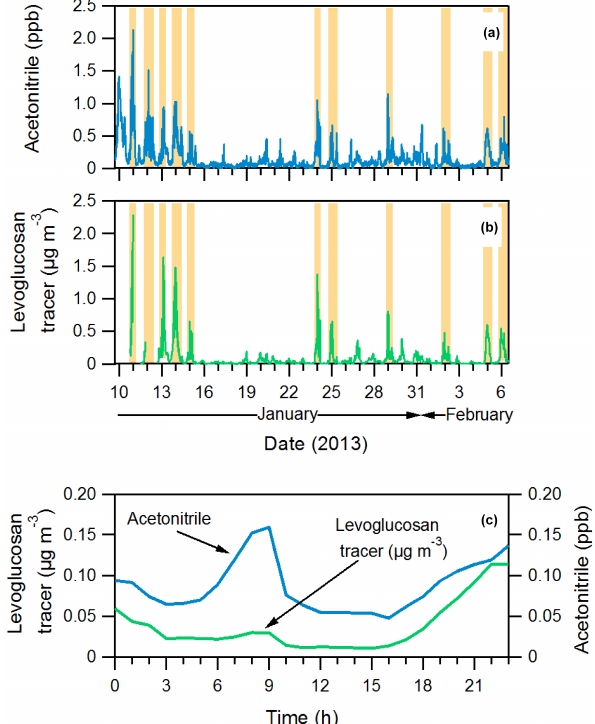
Figure 5. Time series of (a) AMS levoglucosan tracer ( m/z 60 of the AMS) and (b) acetonitrile for the Athens winter campaign. Light brown indicates periods where wood burning contributed sub- stantially to the total VOC and particulate levels. Also shown (c) are their average diurnal